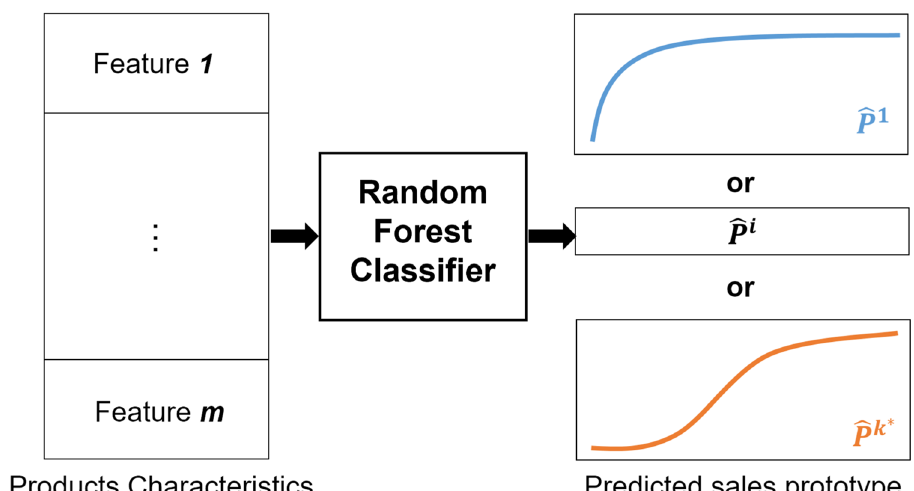
Fig. 5 Random forest classifica-